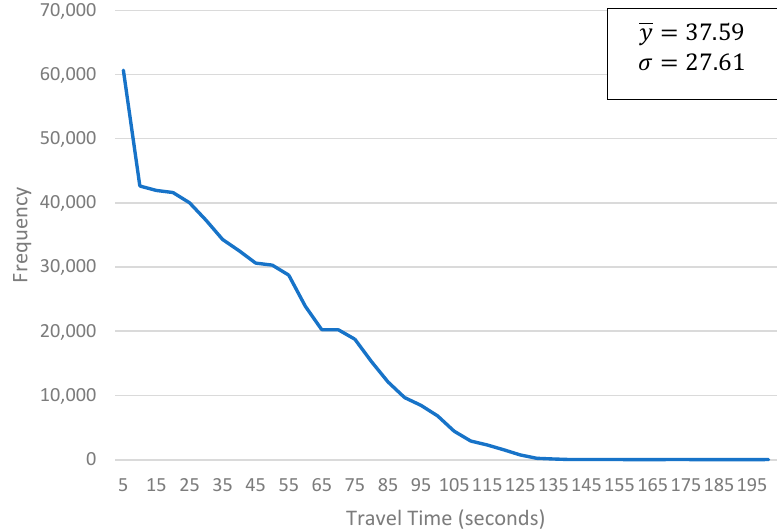
Figure 8. Histogram for initial_values dataset, mean and standard deviation.